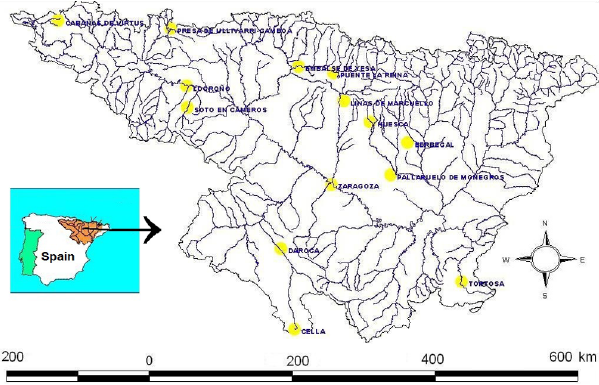
Fig. 1. Distribution of 14 rainfall gauges in the Ebro River Basin (Spain).